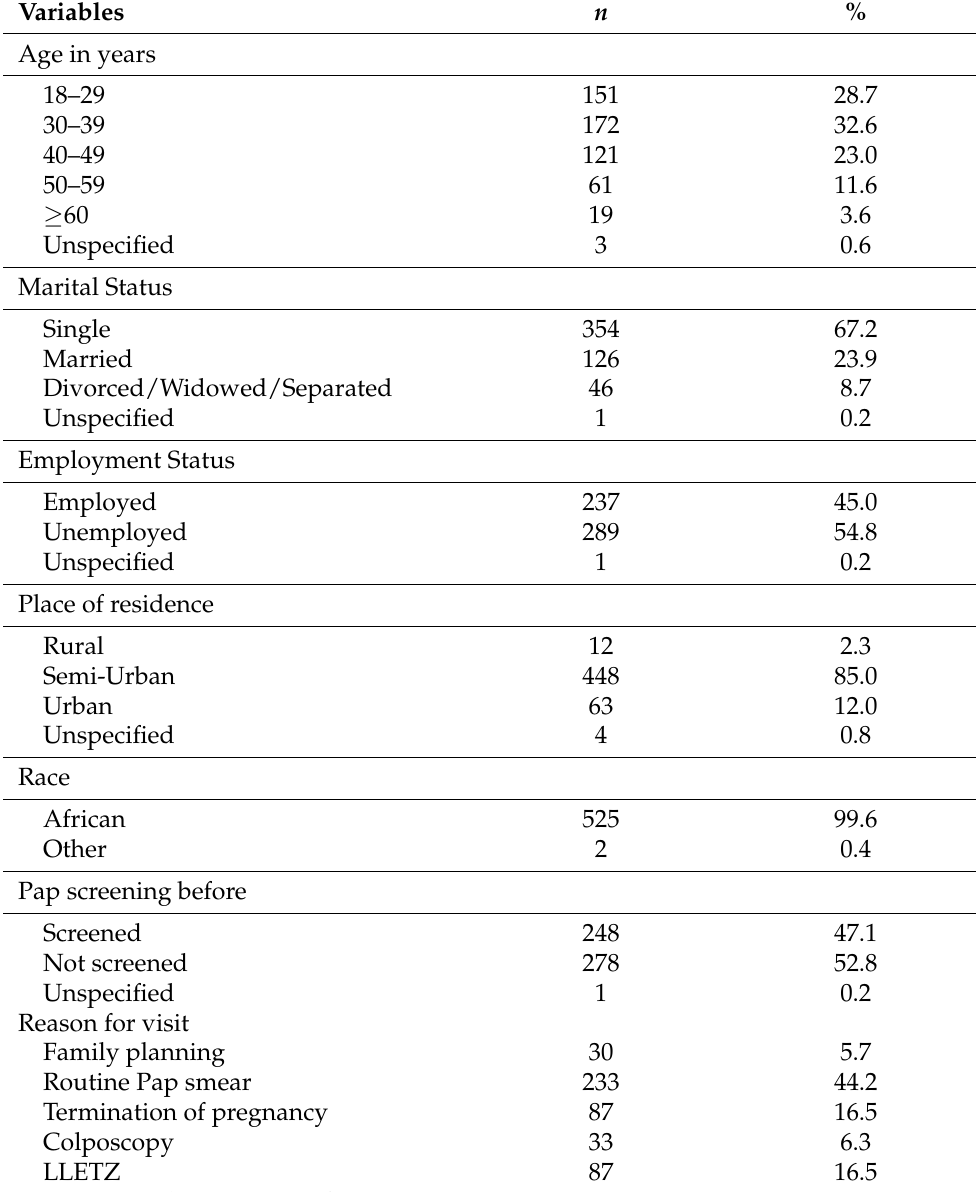
Table 1. Demographic characteristics of the study participants ( n =